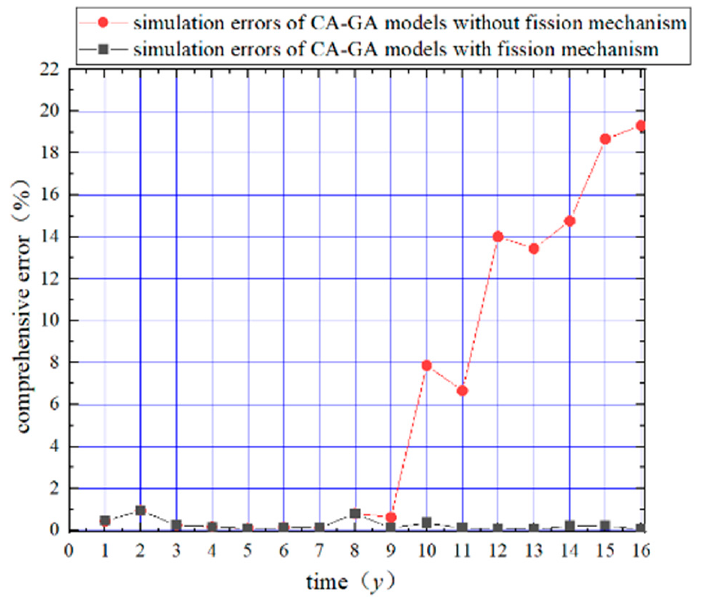
Figure 5. Comprehensive errors comparison of simulation results with and without cellular fission mechanism.